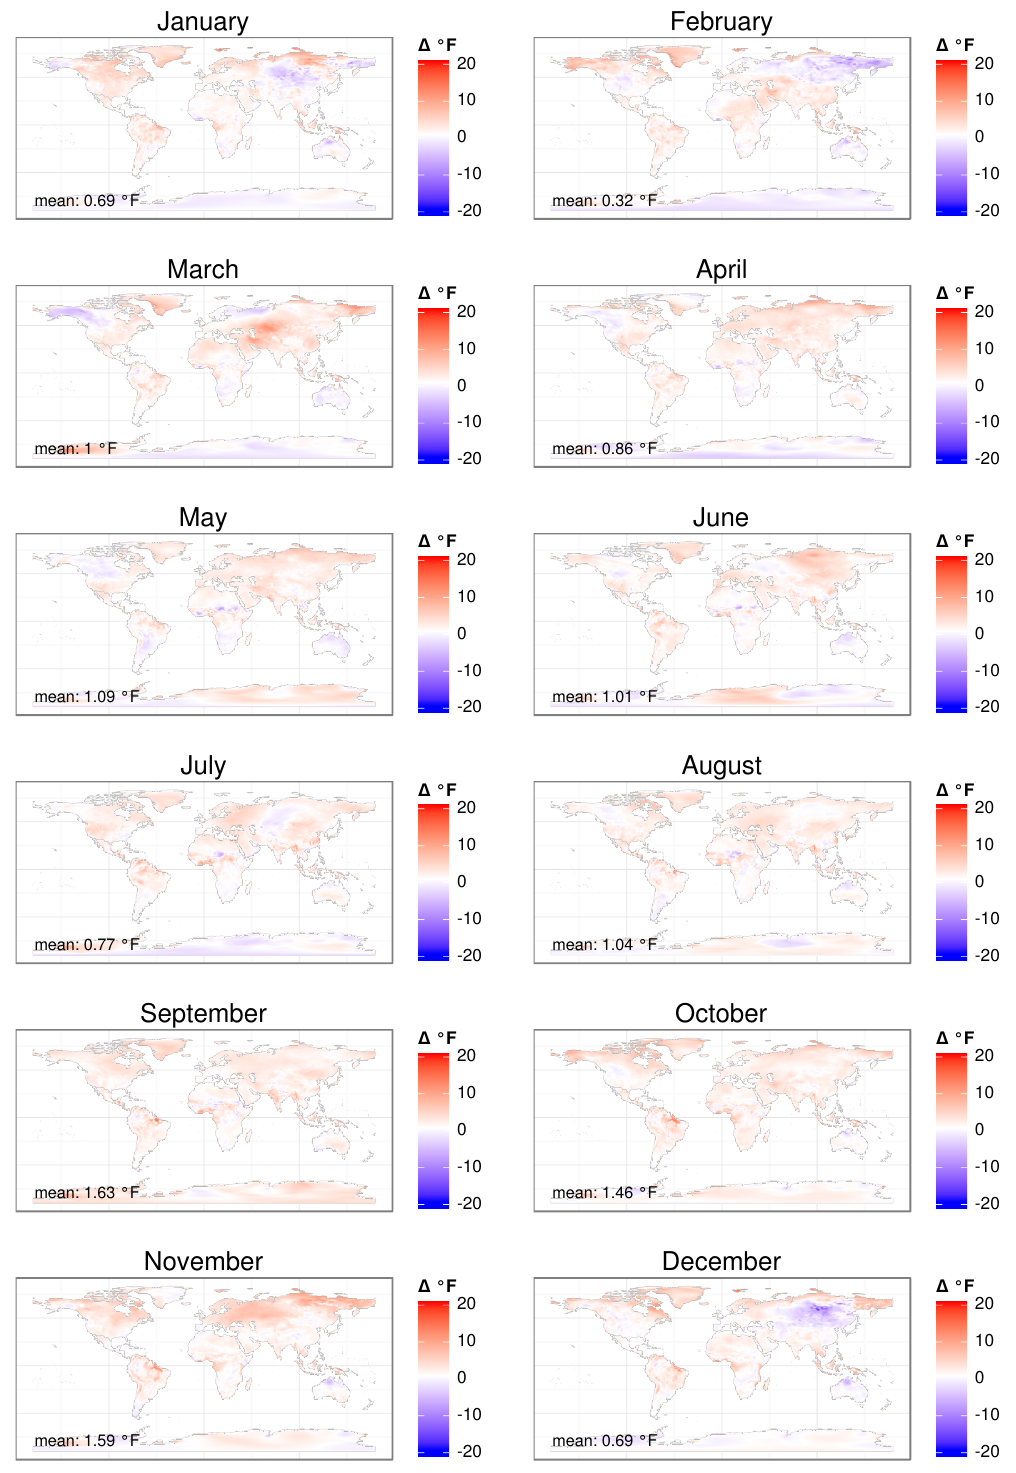
Figure 3. Changes between both reference periods (1979–1999, 2000–2013) in monthly mean heat index. The inset numbers refer to the mean increase in heat index for the month in question between both reference periods. Continents are added for orientation (South, 2011; Bivand and Rundel,